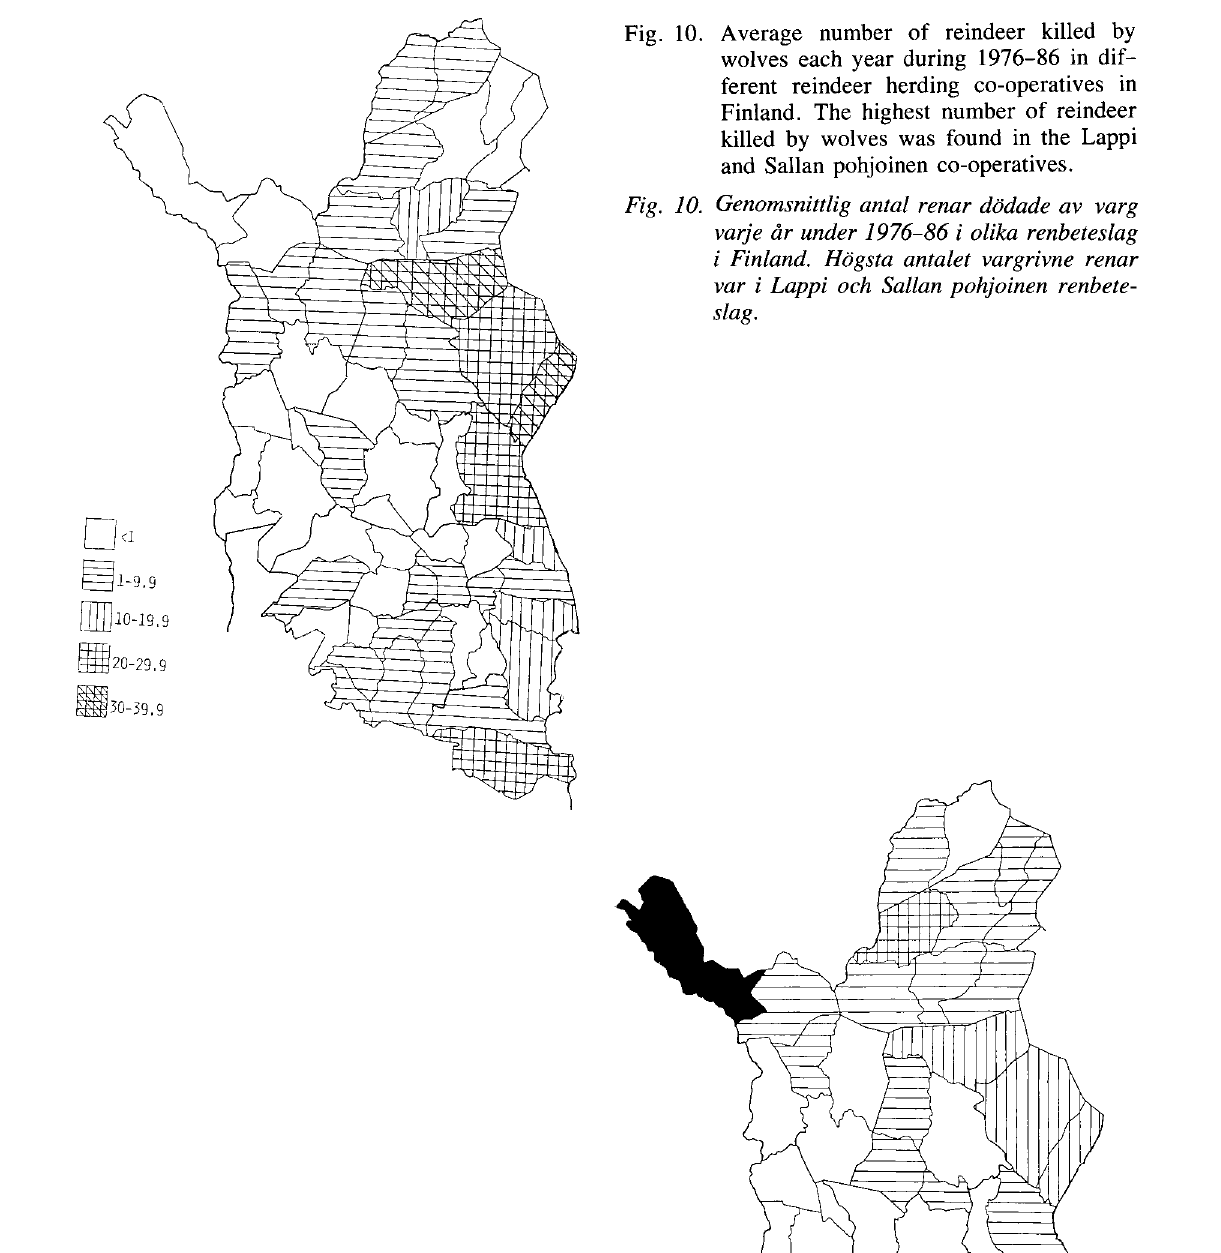
Fig. 11. Average number of reindeer killed by wolverines during 1976-86 in different reindeer herding co-operatives in Finland. The highest number of reindeer killed by wolverines was found in the Kasivarsi co operative. Fig. 11 Genomsnittlig årlig antal renar dodade av jarv under 1976-86 i olika renbeteslag i Finland. Hogsta antalet renar rivna av jarv funnits i Kåsivarsi renbeteslag.